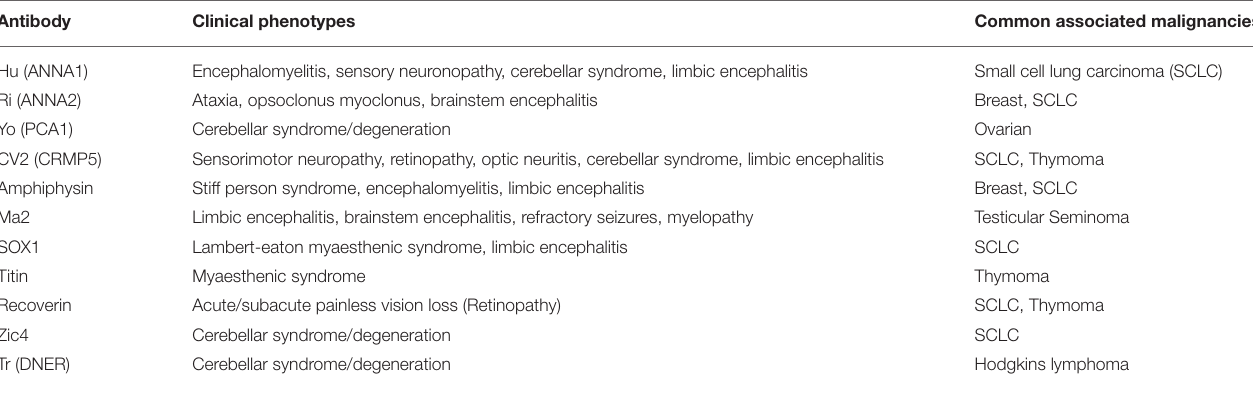
TABLE 1 | Intracellular antibody associated AIE